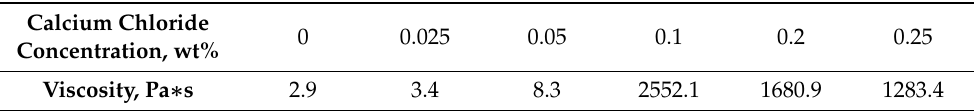
Table 1. Low shear rate viscosity of the 2 wt% alginate solution and gel-like materials with different calcium chloride concentrations.